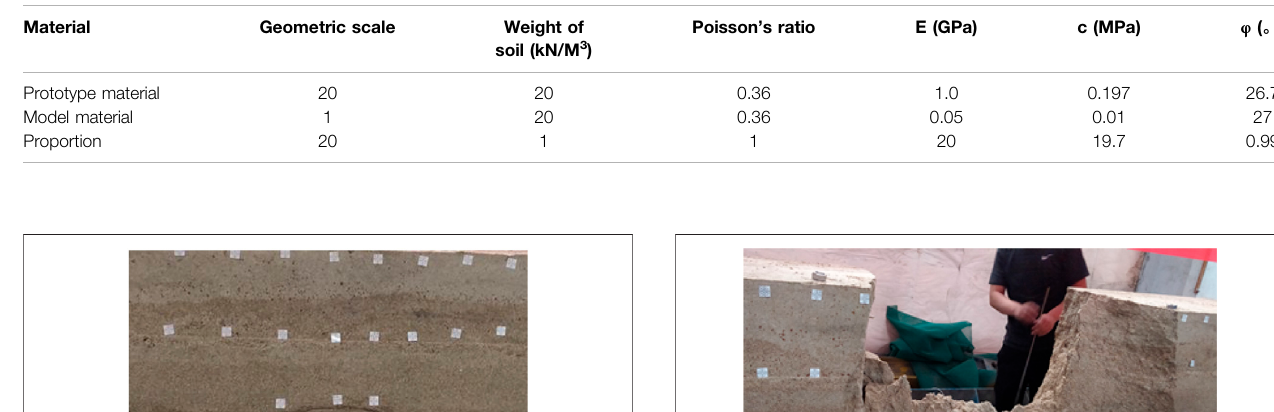
TABLE 1 | Physical and mechanical parameters corresponding to prototype materials and model materials.